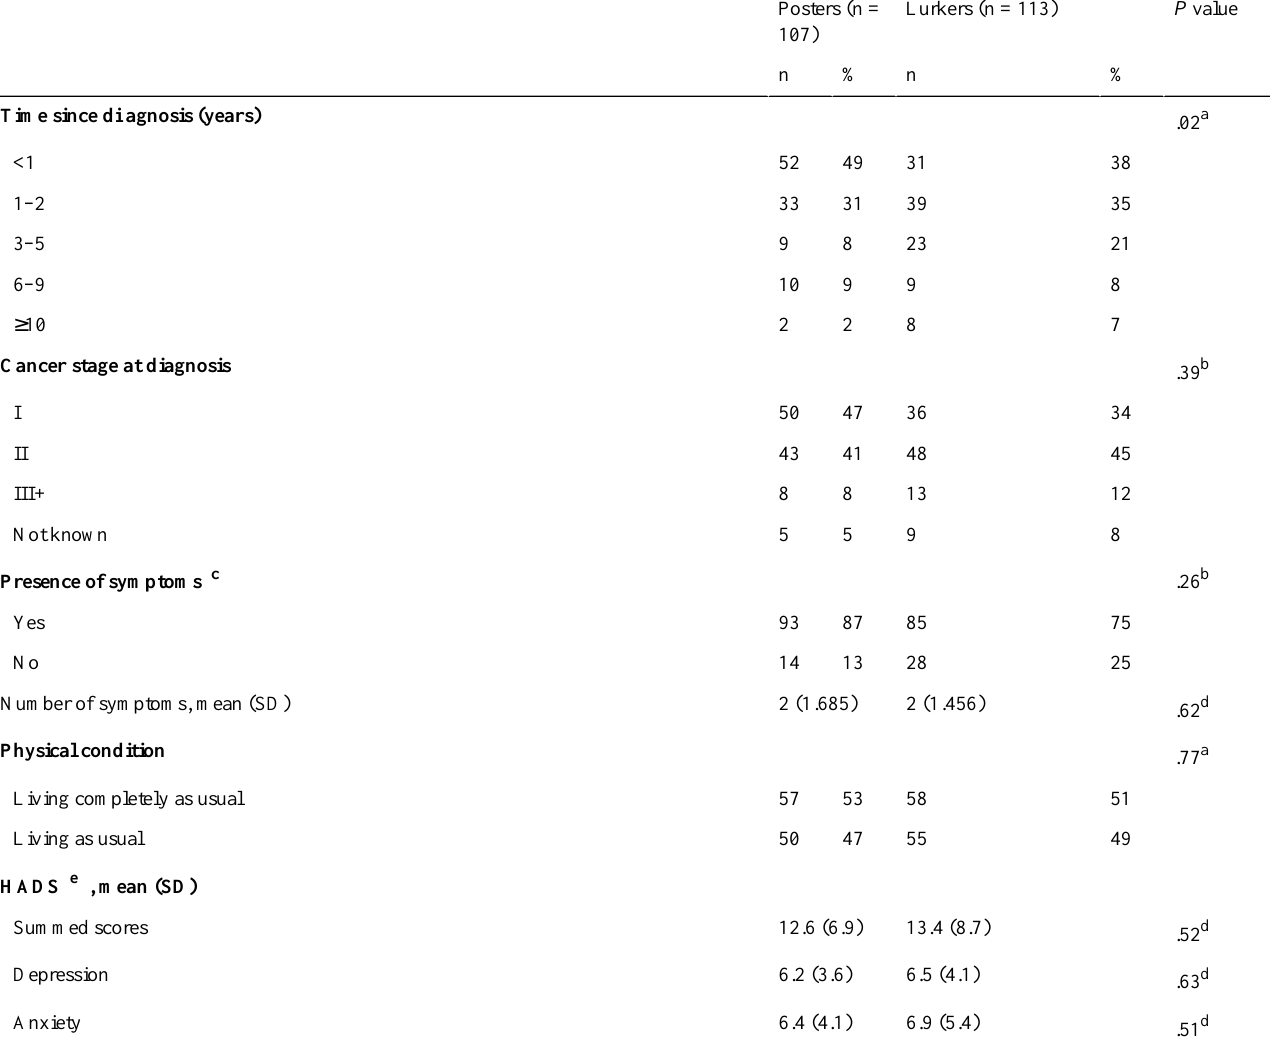
P valueLurkers (n = 113)Posters (n